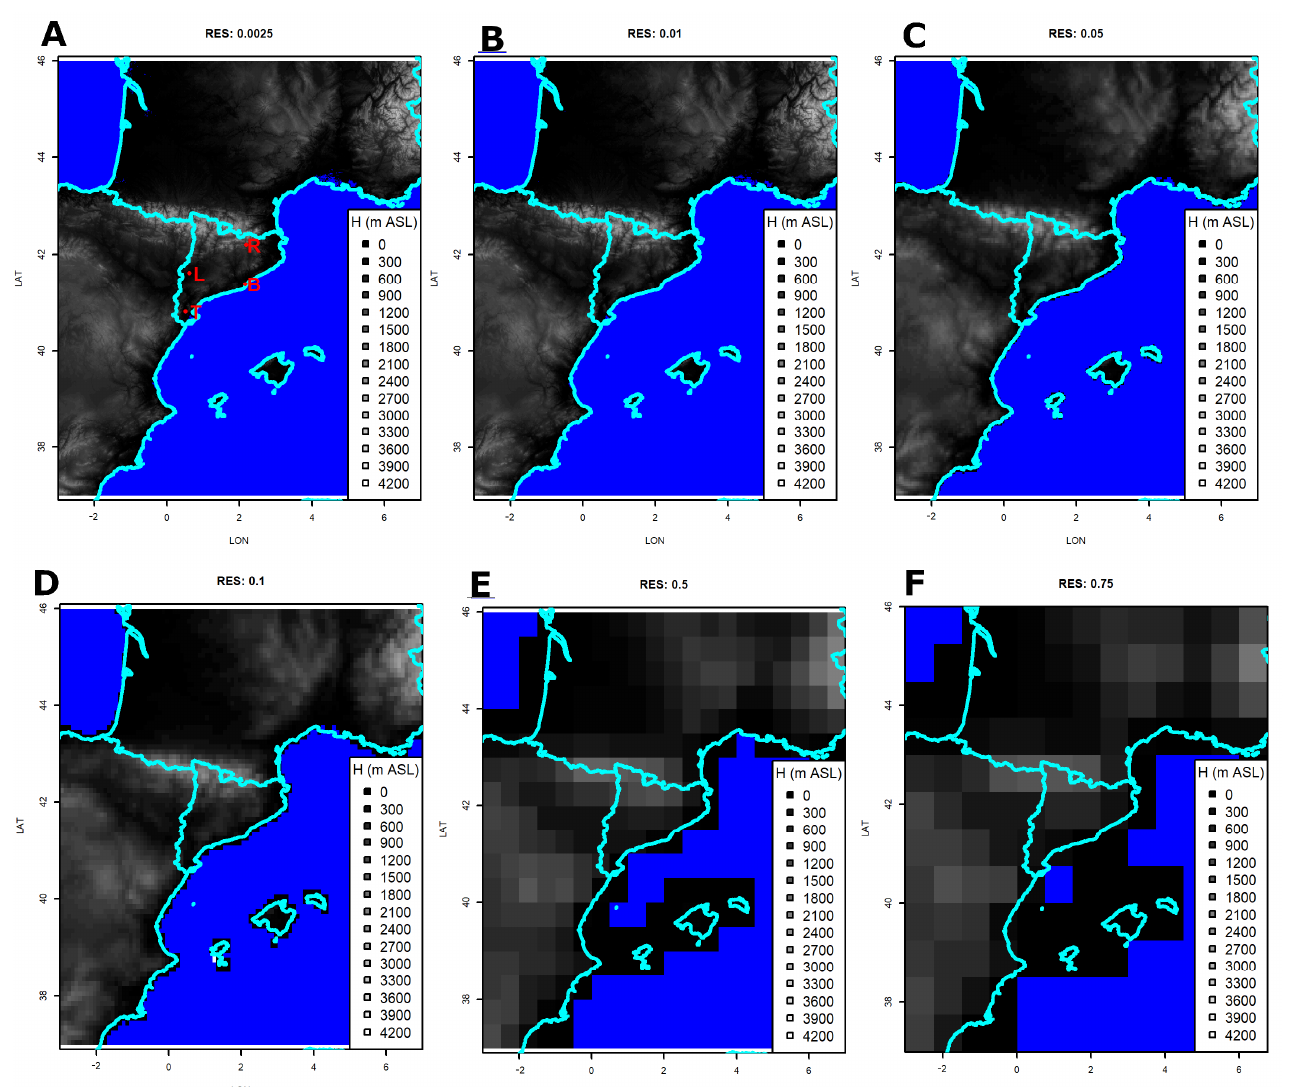
Figure 3. DEM field used in the current analysis. Panel ( A ), the original map, with a resolution of 0.025° × 0.025°. The rest of the panels are reconstructions using different pixel resolutions: 0.01° × 0.01° panel ( B ), 0.05° × 0.05° panel ( C ), 0.1° × 0.1° panel ( D ), 0.5° × 0.5° panel ( E ), and 0.75° × 0.75° panel ( F ). The red points of panel A indicate the locations of different cities of Catalonia: Barcelona (B), Ripoll (R), Lleida (L), and Tortosa (T). Table 1. Height of the pixel corresponding to the center of the cities marked (red dots) in panel A of Figure 3, according to the different resolutions of the pixels indicated in the same figure.